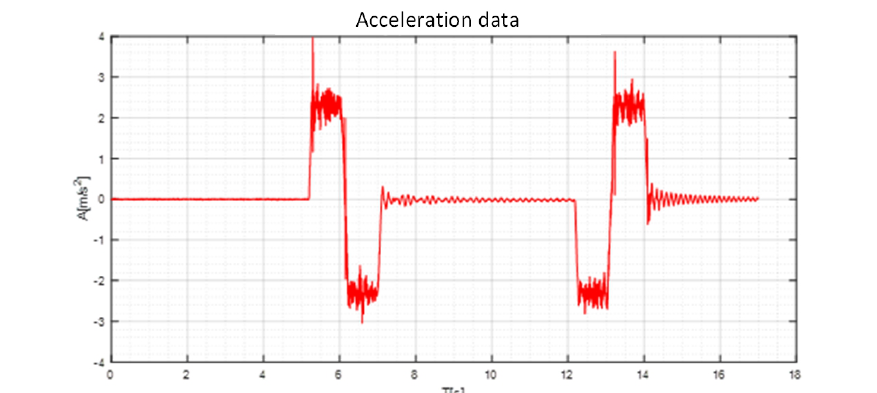
Figure 6. Acceleration plot obtained with MTi XSENS installed on robot flange and welding gun for V2000,